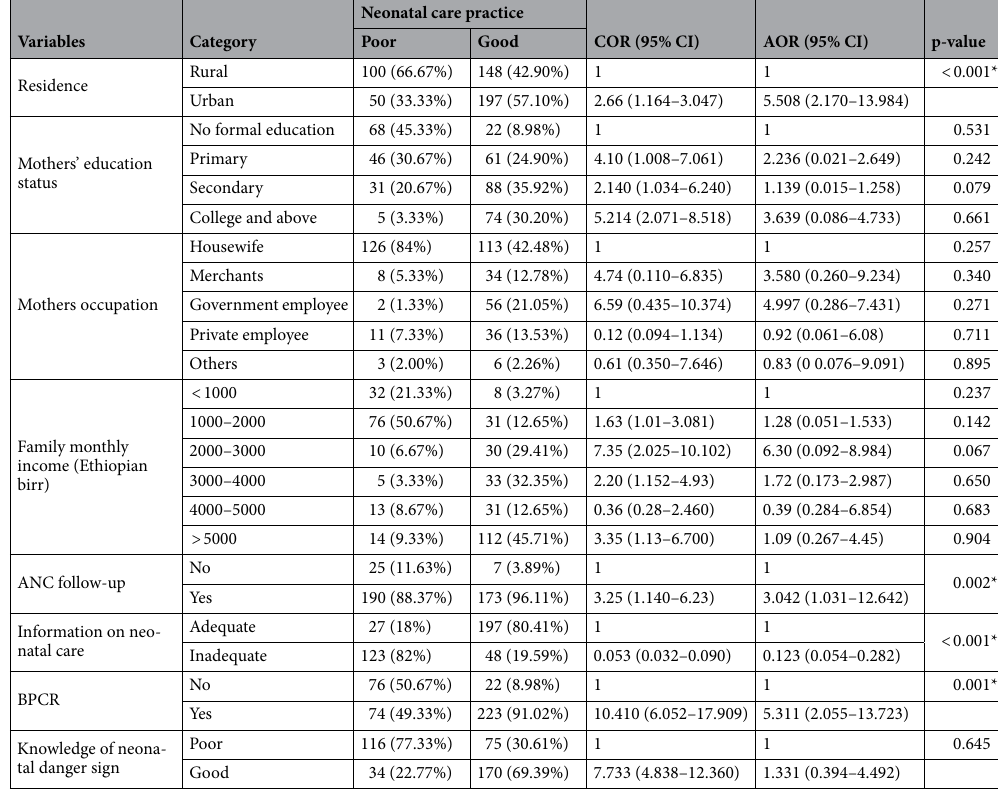
Table 4. Multivariate logistic regression analysis result of factors associated with neonatal care practice among mothers of infants 0–6 months in North shewa zone, Oromia region, Ethiopia (N = 395). CI confidence interval, COR crude odd ratio, AOR adjusted odd ratio. *p-value <